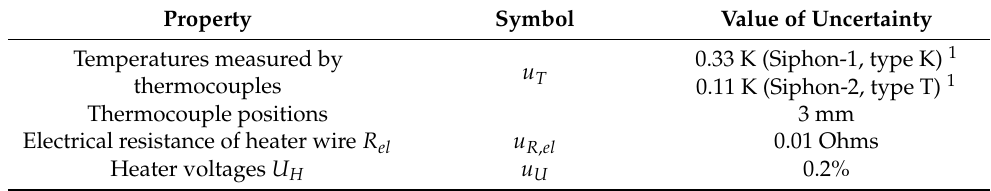
Table A2. Uncertainties taken into account for determining the uncertainties on R sys and R S − S . Property Symbol Value of Uncertainty Temperatures measured